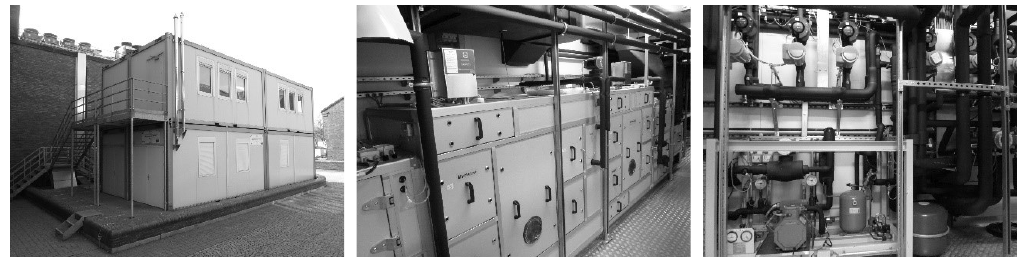
Figure 1. Test facility, air handling unit and heat pump with parts of the header system.